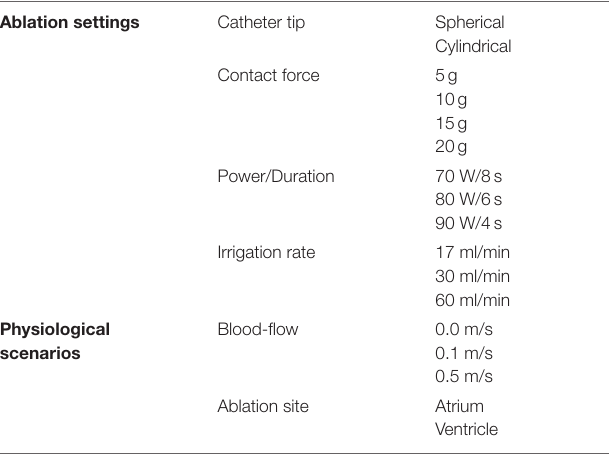
TABLE 1 | Summary of the different ablation settings and physiological scenarios considered combining catheter tip, contact force, power, duration, irrigation rate, blood flow, and cardiac